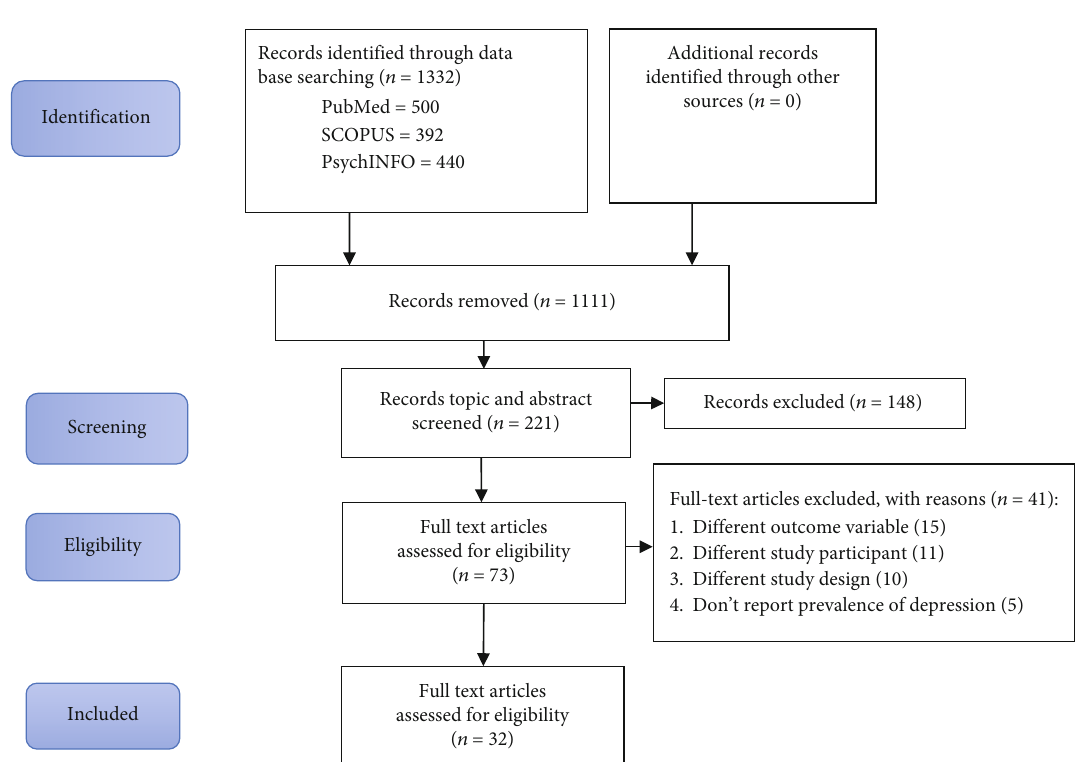
Figure 1: PRISMA fl ow chart of the study identi fi cation process for systematic reviews and meta-analyses,